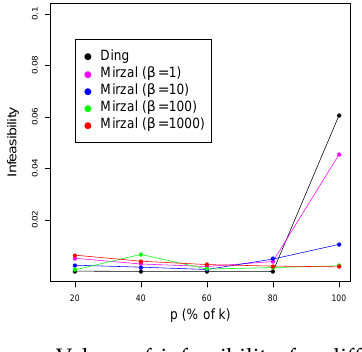
Values of infeasibility for different values of β obtained by Algorithms 1 and 3 on BION data with n = 100.